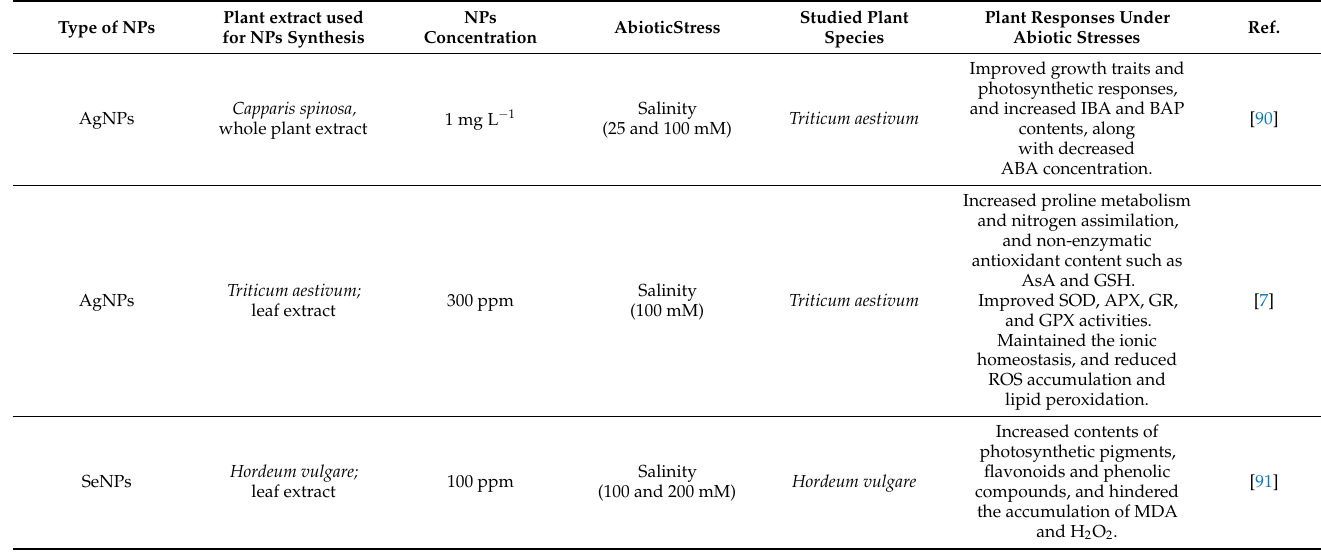
Table 3. Impact of green synthesized nanoparticles in amelioration of abiotic stress in